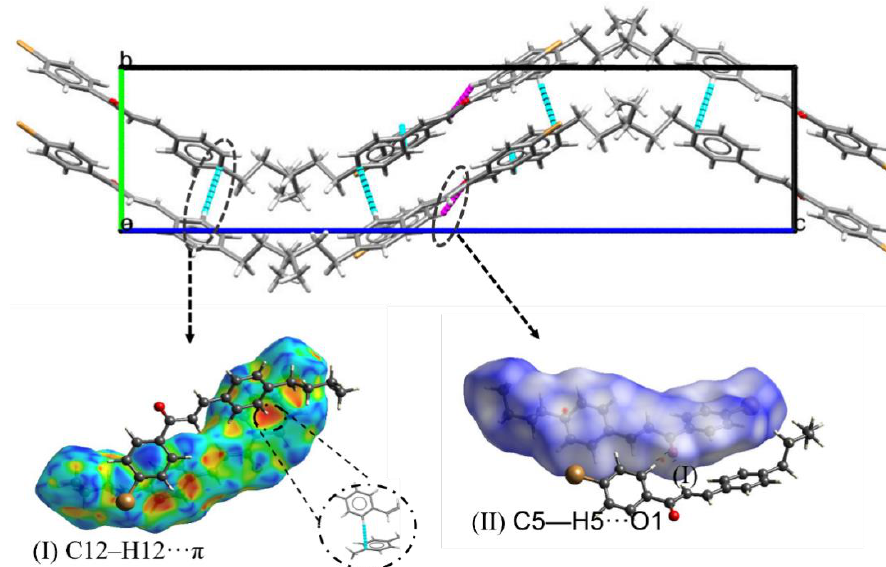
Figure 12. Present the packing stabilized by C – H ⋯ O and the C — H ⋯ π . Interactions that are con- firmed by Hirshfeld surface shape index ( I ) showing the edge-to-face C – H ⋯ π interactions and the Hirshfeld surface dnorm map ( II ) showing C — H ⋯ O interactions for BBP.